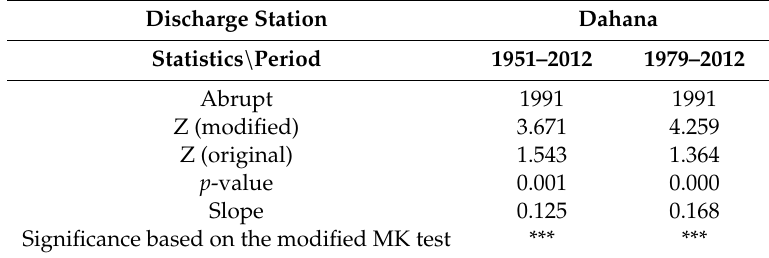
Table 9. The annual flow trends, the Sen’s slope, the abrupt-point analysis, and the modified and